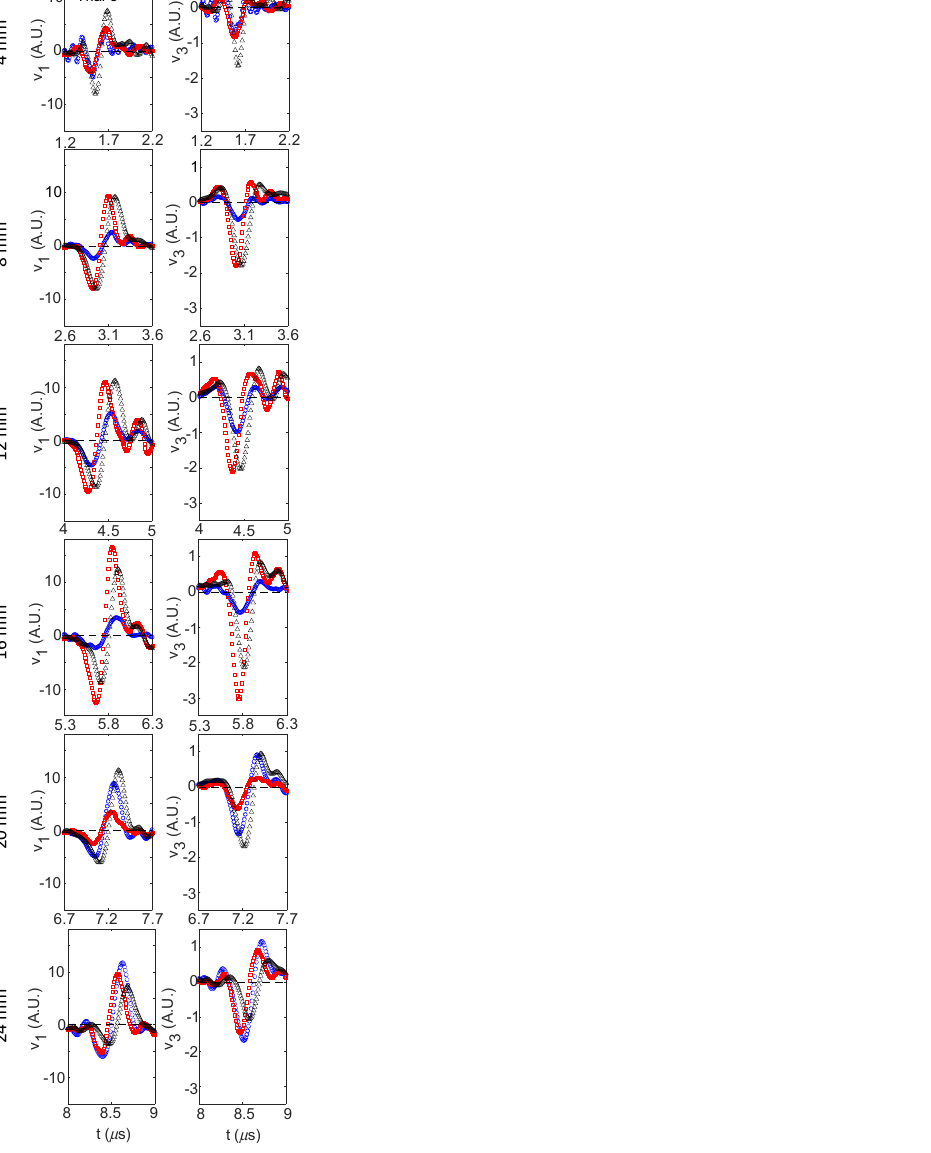
Figure 9. Sample v 1 and v 3 velocity waveforms derived from the displacement waveforms in Figure 6.